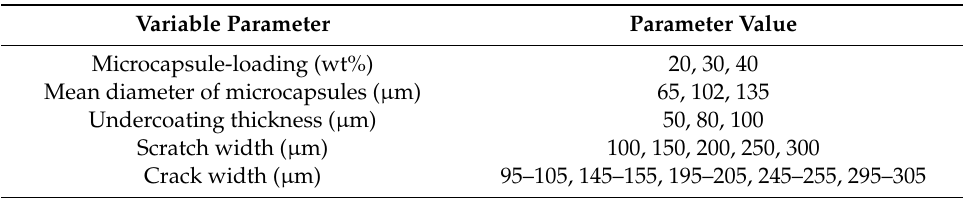
Table 1. Variable parameters of the coating